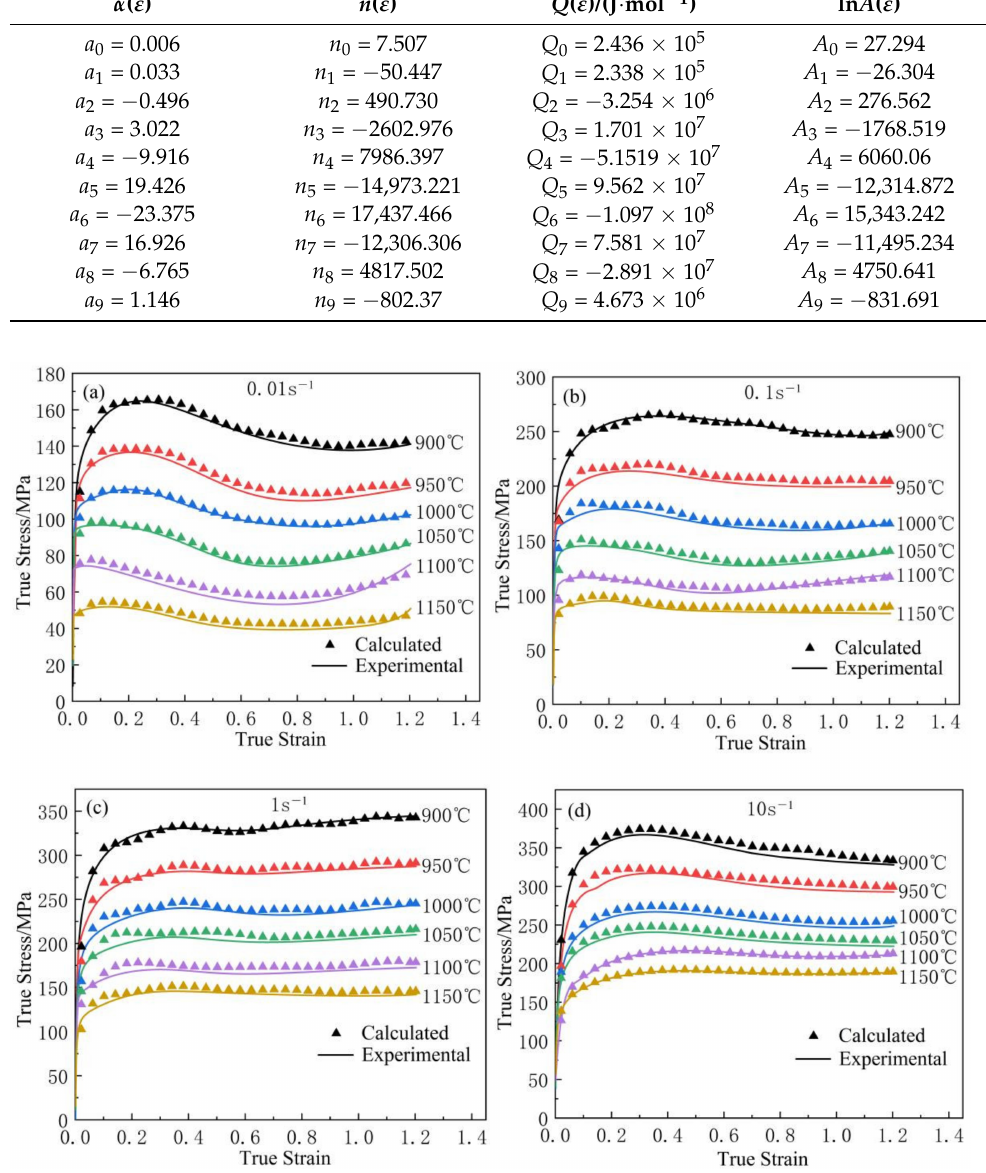
Figure 5. The comparison between predicted and experimental flow stress values under different deformation conditions: ( a ) 0.01 s − 1 ; ( b ) 0.1 s − 1 ; ( c ) 1 s − 1 ; and ( d ) 10 s − 1